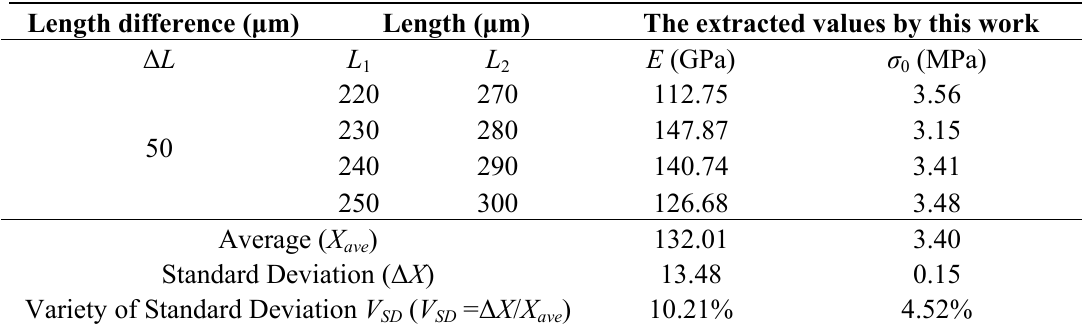
Table 8. Extracted Young’s modulus and mean stress of structural material fabricated